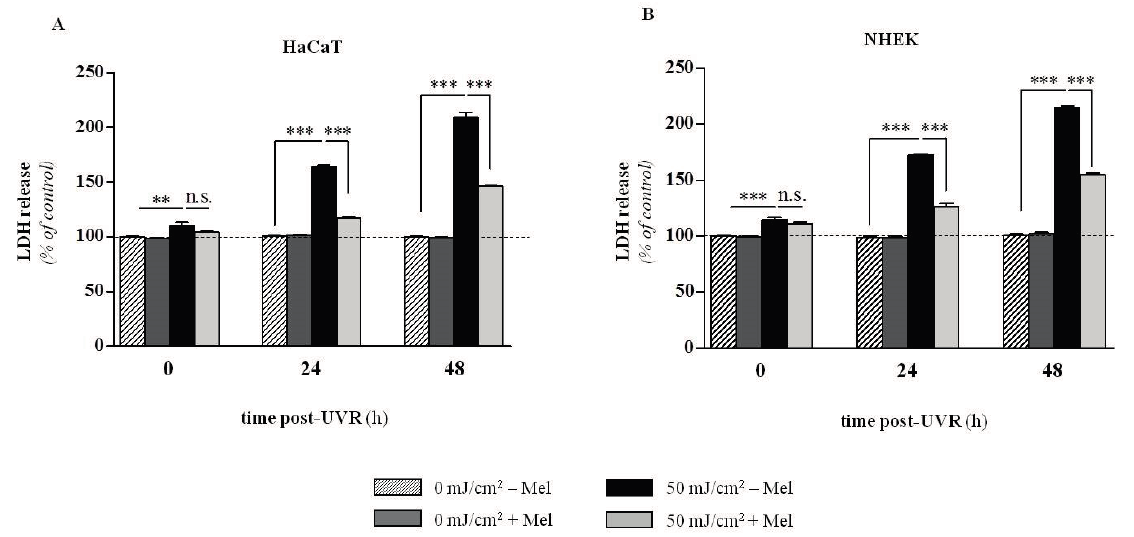
Figure 4. Presentation of UVR-induced release of LDH in human keratinocytes in dose- and time-dependent manner. Investigation was conducted using immortalized (HaCaT) ( A ) and normal (NHEK) ( B ) keratinocytes first pre-incubated with melatonin for 1 h (10 − 3 M) and irradiated with the UVB dose of 50 mJ/cm 2 . Data were presented as the mean ± SEM of three independent experiments. Values were normalized and expressed as percentage of the control value, i.e. , sham-irradiated sample (0 h 0 mJ/cm 2 ) without melatonin (Mel). Statistically significant differences in melatonin versus non-melatonin treated samples at corresponding UVR doses and time points post-UVR were indicated as ** p < 0.01; *** p < 0.001; n.s., not significant, using the ANOVA with appropriate post-hoc testing (modified after Kleszczy ń ski et al. [142] with permission from the